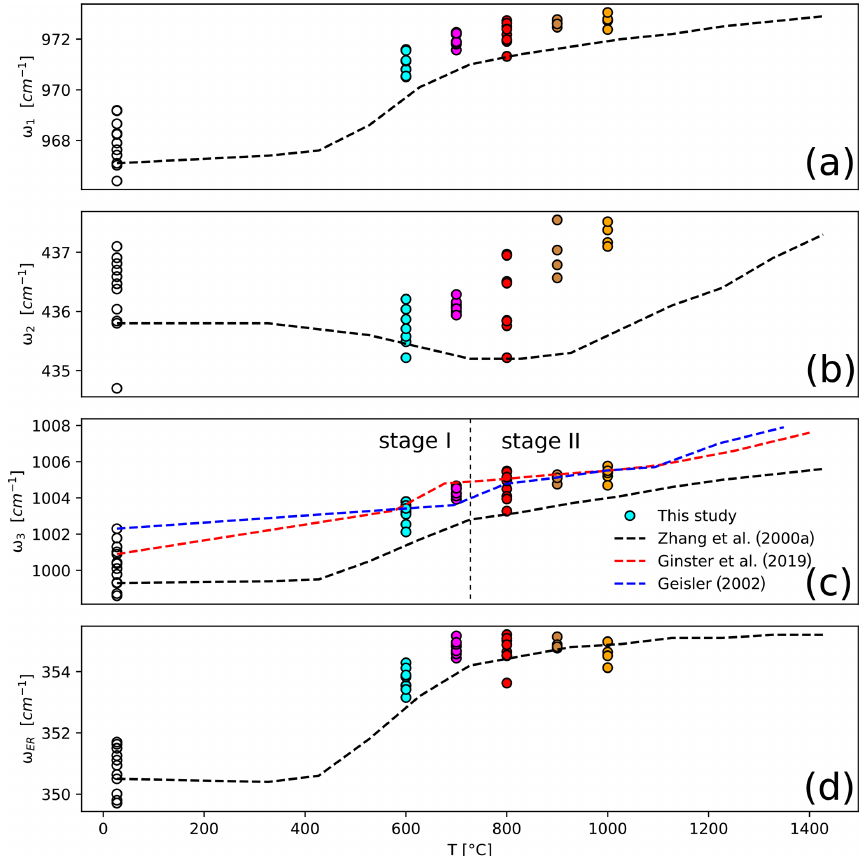
Figure 5. ω –temperature plots of the ν 1 (SiO 4 ) (a) , ν 2 (SiO 4 ) (b) , ν 3 (SiO 4 ) (c) , and ER (d) Raman bands for the isochronal experiments compared with the 1h isochronal annealing data of Zhang et al. (2000a) and the 90min annealing experiments of Geisler (2002) and Ginster et al.